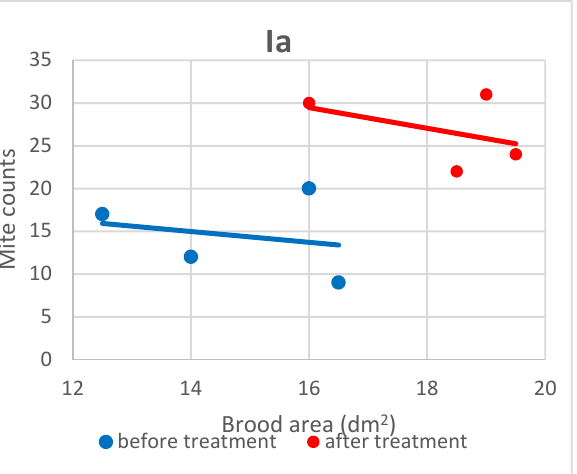
Figure 2. Linear regression plots of brood area (fixed factor) and mite counts in Group II before treatment.